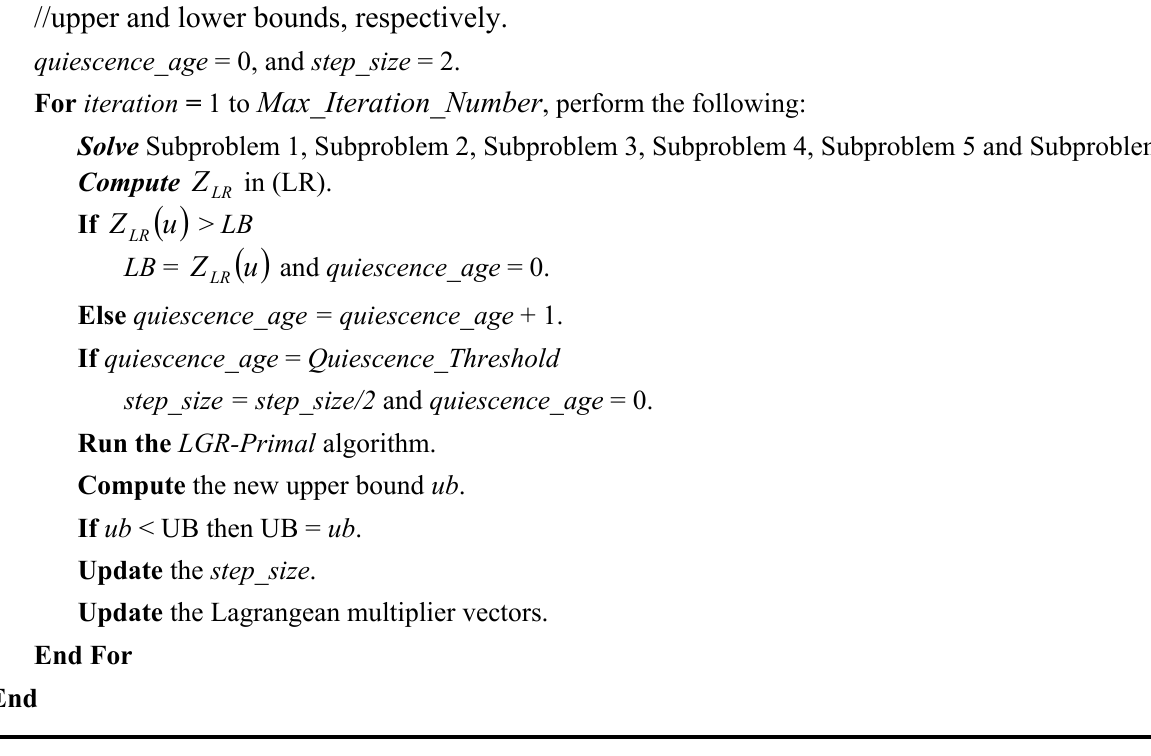
Algorithm 1: The LGR Algorithm